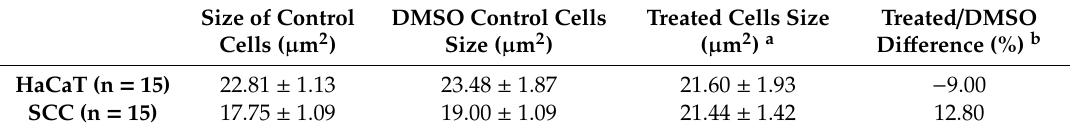
Table 4. The e ff ect of compound 10 on the size of mother